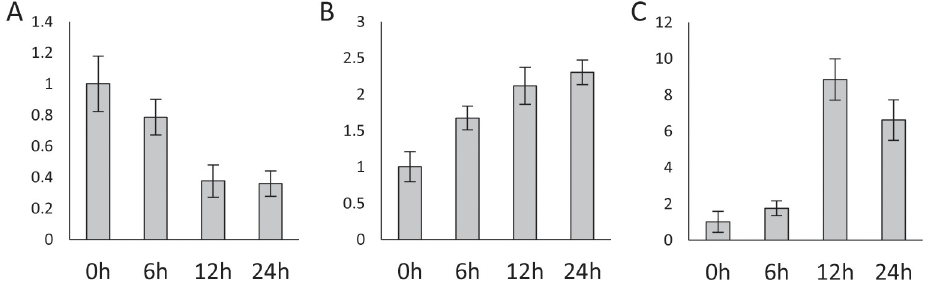
Fig 5. The expression of miR164 and target genes in leaves under ABA treatment. (A) miR164. (B) GRMZM2G114850 (NAC). (C) GRMZM2G096358 (MYB).